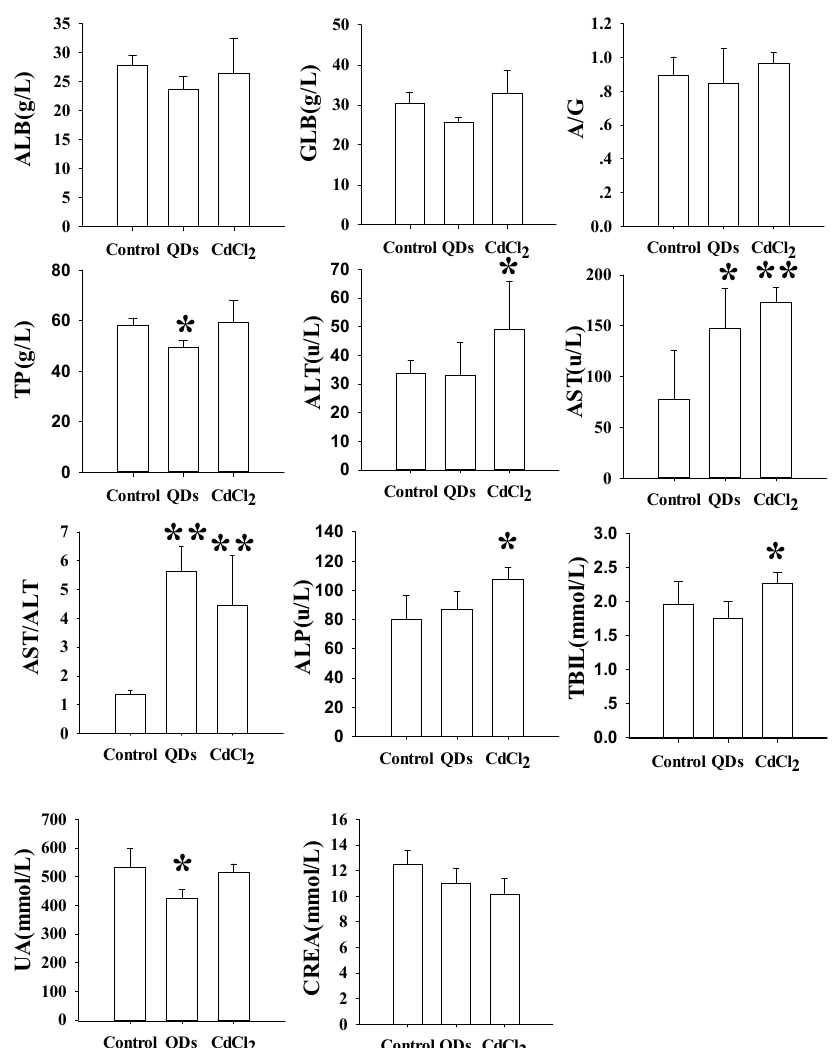
Figure 4. Serum biochemical analysis of F1 mice sacrificed at PND 60. * p < 0.05, ** p < 0.01 vs. control. albumin (ALB), aspartate aminotransferase (AST), total protein (TP), globulin (GLB), total bilirubin levels (TBIL), the ratio of albumin to globulin (A/G), alkaline phosphatase (ALP), alanine aminotransferase (ALT), the ratio of aspartate aminotransferase to aspartate aminotransferase (AST:ALT ration), Creatinine (Cr), uric acid (UA).